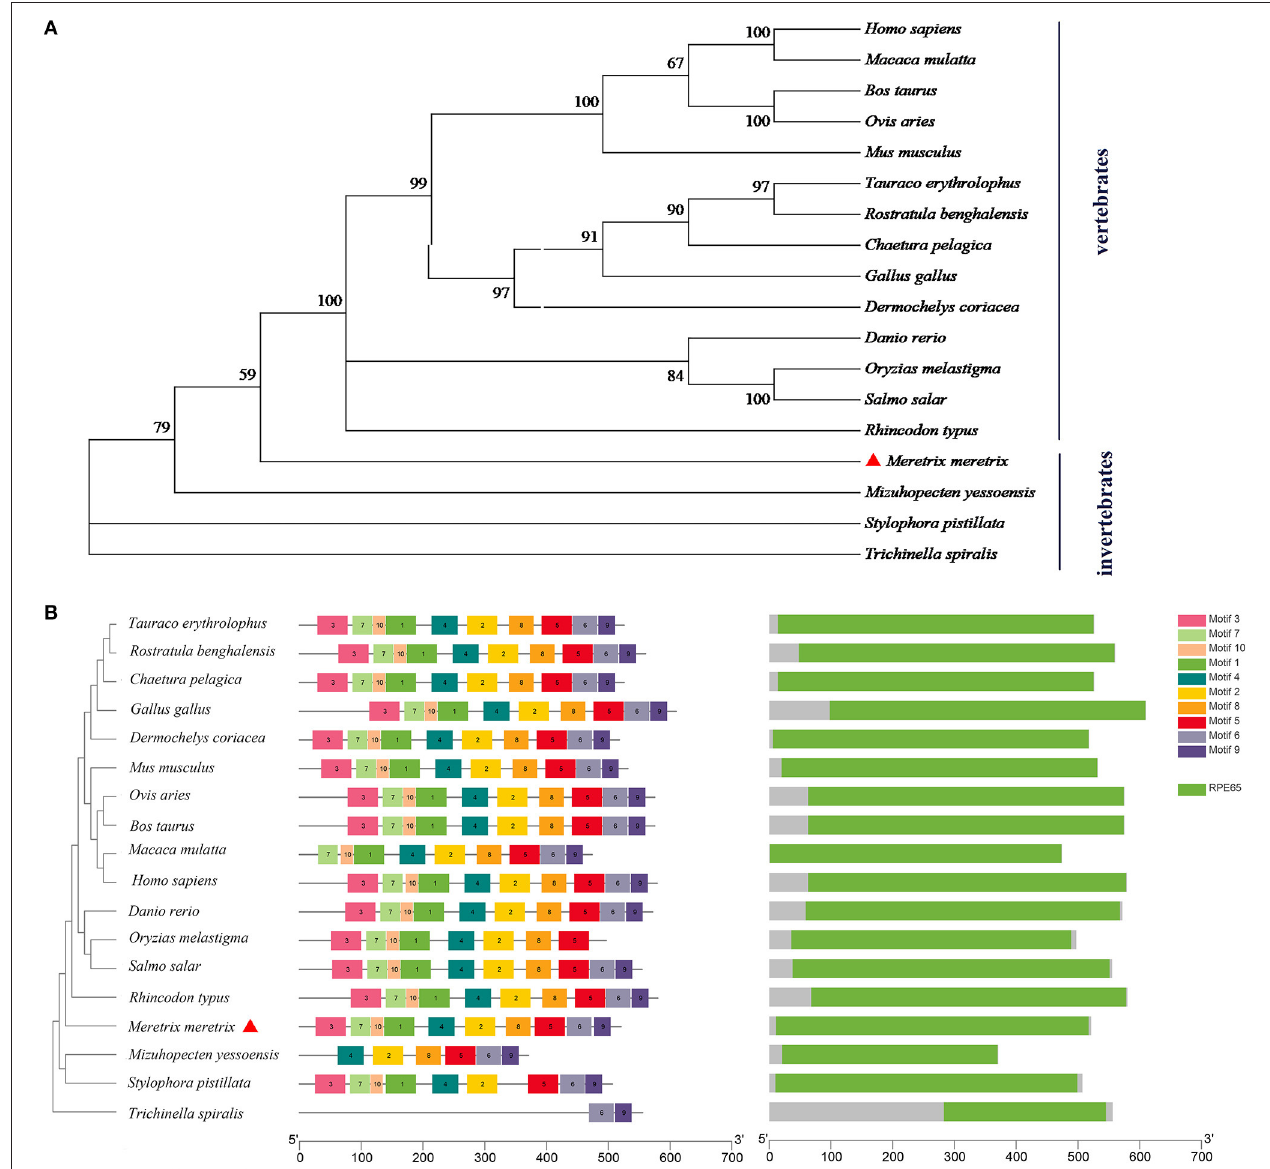
FIGURE 2 | Analysis of evolutionary relationship among species. (A) Phylogenetic tree analysis of BCDO2 protein between M. meretrix and other species. (B) The structure of BCDO2 of M. meretrix , other bivalves and vertebrates.